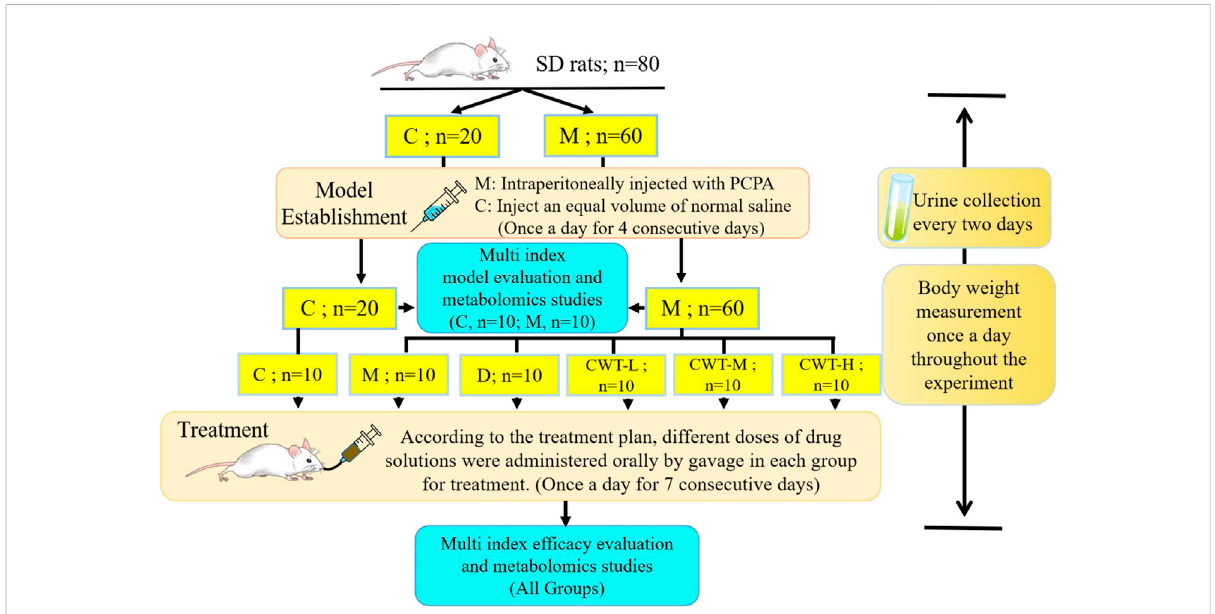
FIGURE 1 Experimental design fl ow chart of insomnia rat model generation and CWT pharmacological effects evaluation. (SD rats, Sprague-Dawley rats; C,controlgroup;M,Modelgroup;D,Diazepamgroup;CWT-L,Ciwujiatabletlow-dosegroup;CWT-M,Ciwujiatabletmedium-dosegroup;CWT-H, Ciwujia tablet high-dose group; PCPA, p-chlorophenylalanine; CWT, Ciwujia